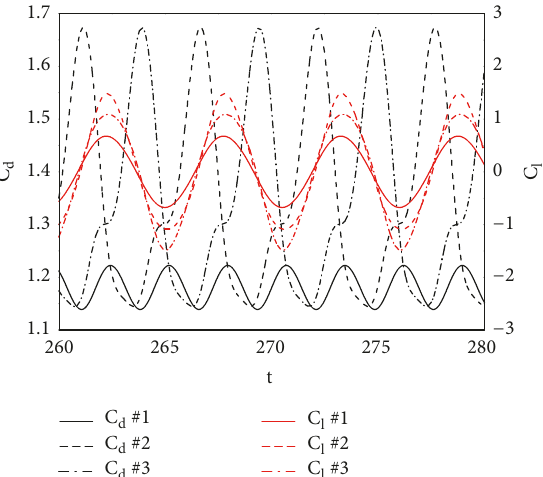
Figure 20: Variations of mean drag coefficients with different spacing distances for three